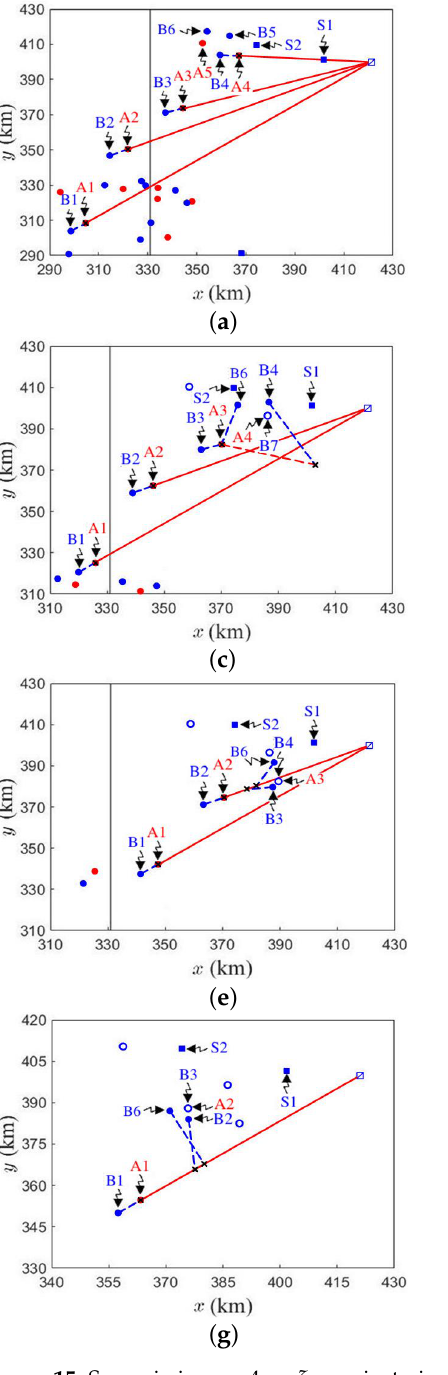
Figure 15. Scenario in case 4 on ζ 1 , against pincer formation, ( a ) t = 540 s; ( b ) t = 560 s; ( c ) t = 620 s; ( d ) t = 680 s; ( e ) t = 700 s; ( f ) t = 720 s; ( g ) t = 760 s; ( h ) t = 780